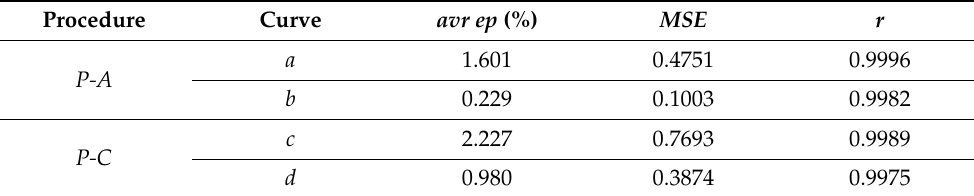
Table 1 includes the maximum values: absolute error— e , mean square error— MSE , and linear regression coefficient— r , which allow for estimating the approximation quality. Table 1. Maximum values of absolute error ( e ), mean square error ( MSE ), and linear regression coefficient ( r ) for P-A and P-C